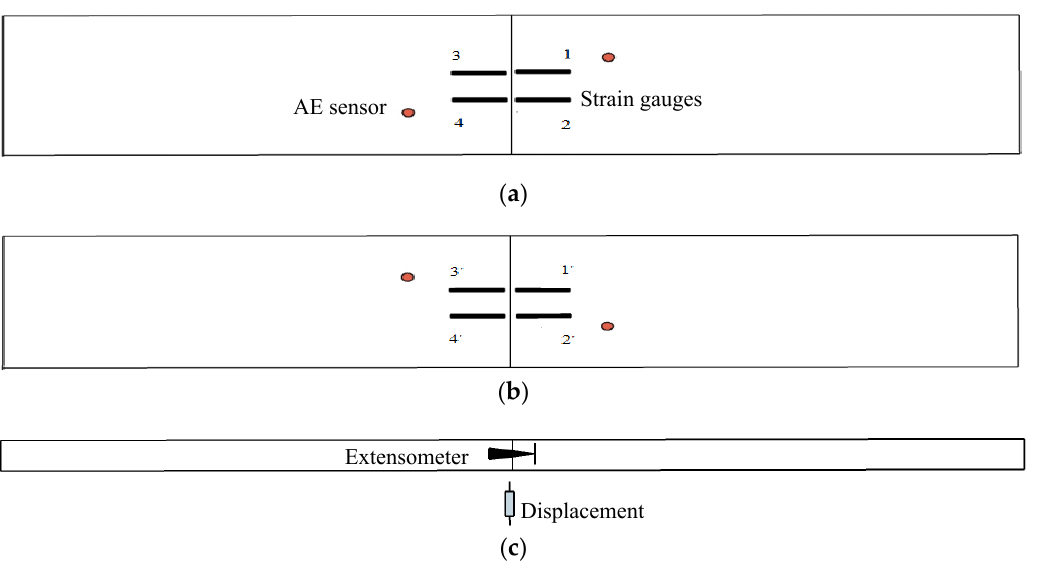
Figure 4. Model loading test device: ( a ) front view; ( b ) top view.